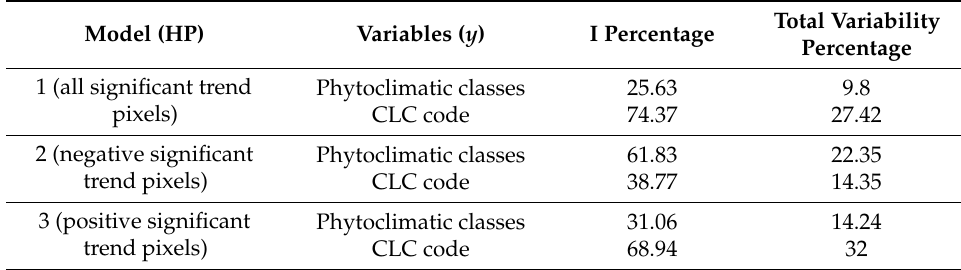
Table 4. Hierarchical partitioning (HP)